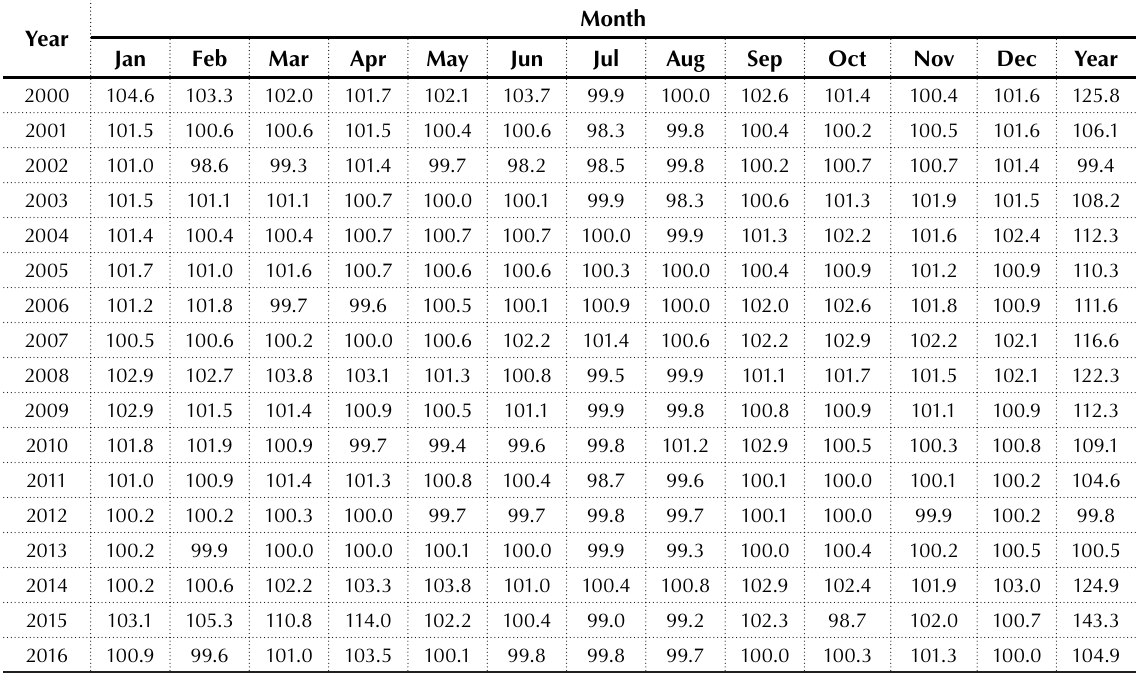
Source: Internet site of the National Bank of Ukraine